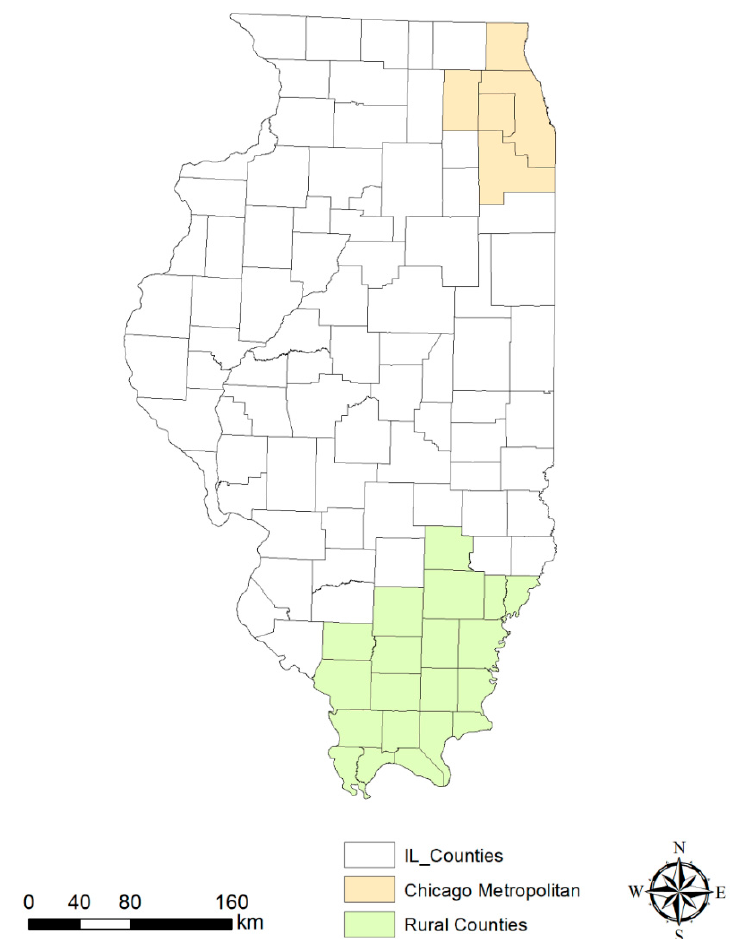
Figure 2. Study areas in Illinois .